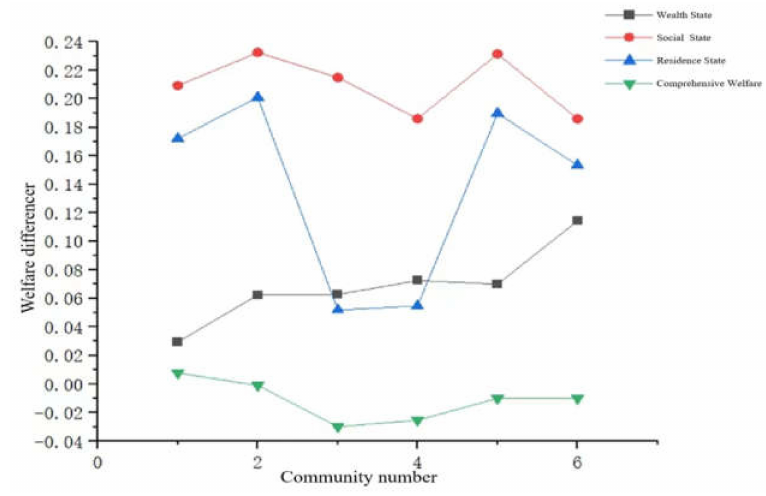
Figure 4. Linear graph of difference between location and welfare.